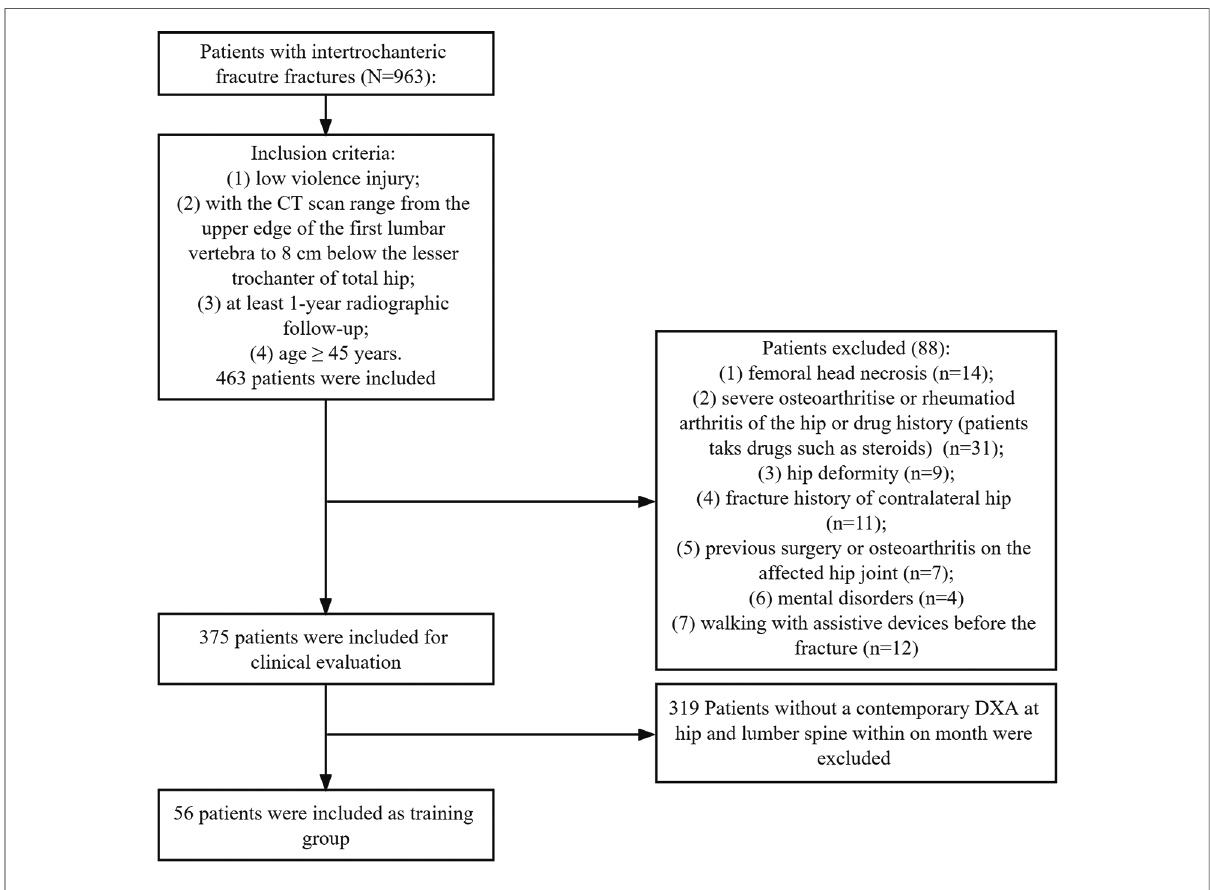
FIGURE 1 Flow chart of the inclusion and exclusion